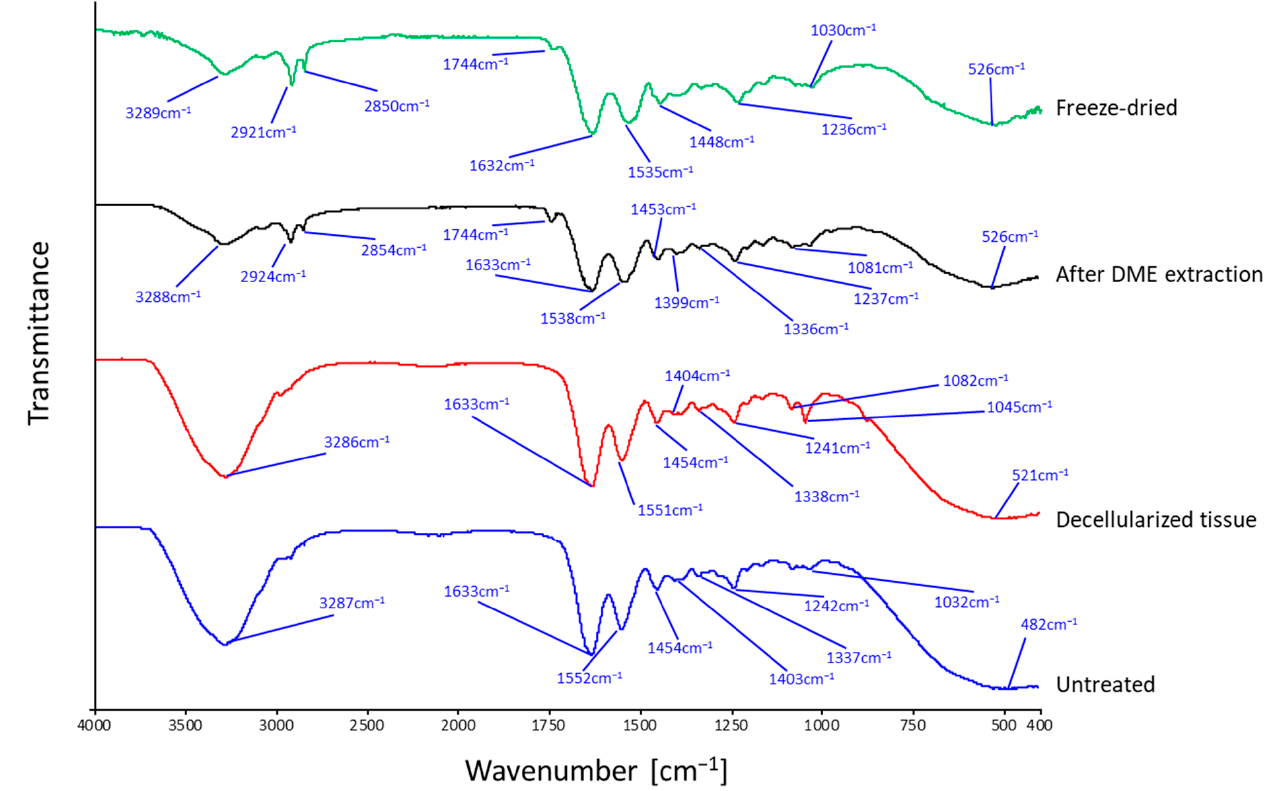
Figure 10. FT-IR spectra of porcine auricular cartilage.